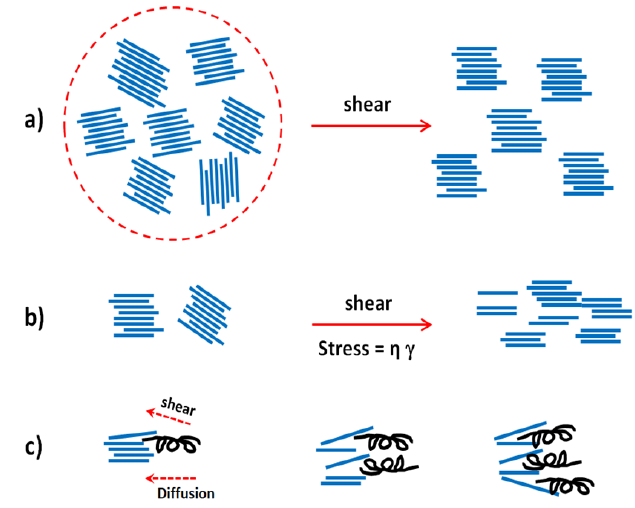
Fig. 4. Mechanism of layered silicate exfoliation during melt compounding of the clay nanocomposites: a) Layered silicate particles breakup; b) layered layered silicate breakup; c) layered silicate exfoliation. Adopted from